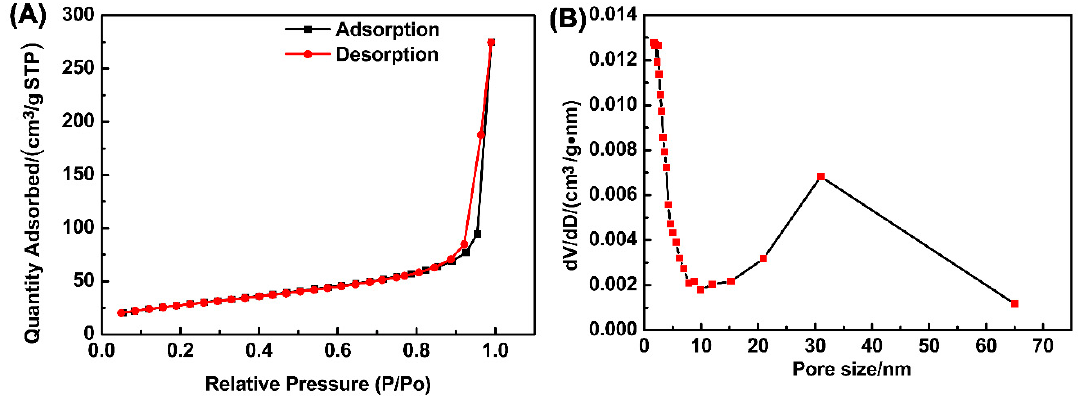
Figure 3. Nitrogen absorption-desorption isotherms of Cu 2 O ( A ); Pore size distributions of Cu 2 O ( B ).